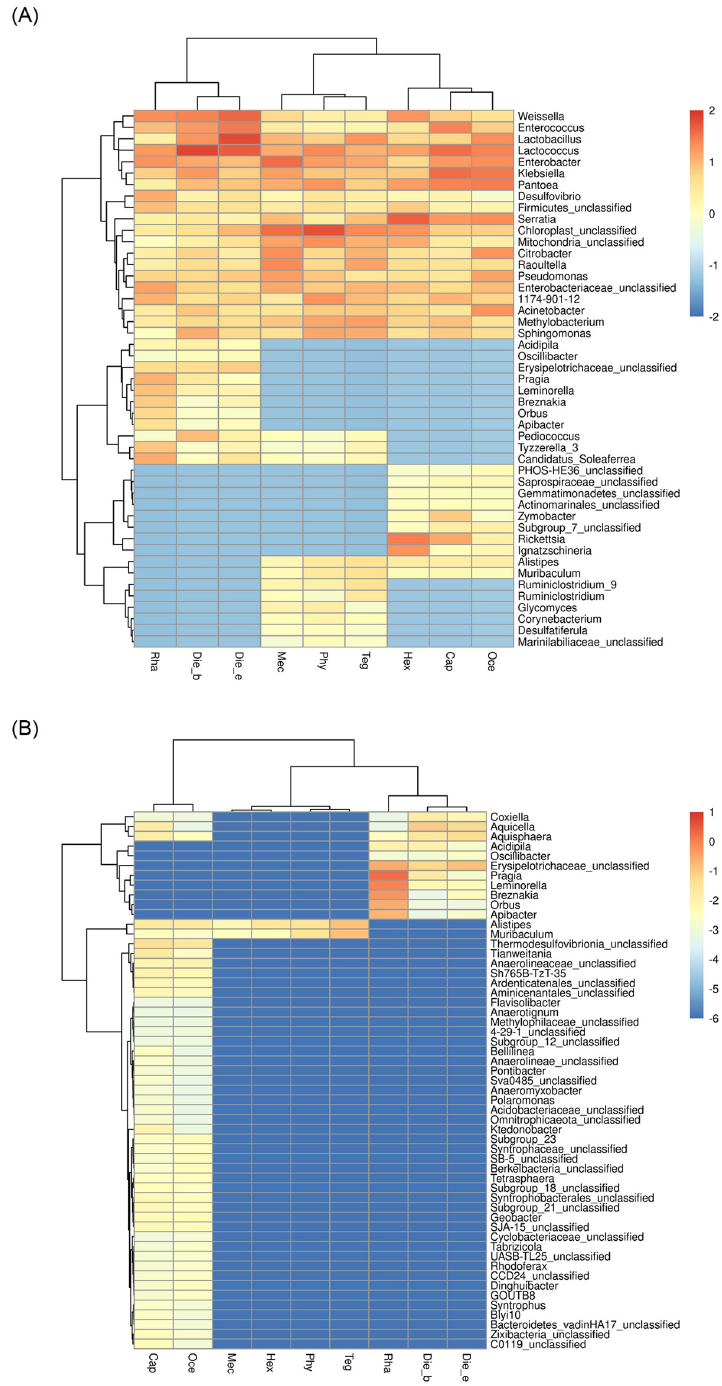
Fig 7. Heat map illustrating the common and endemic bacteria community abundances according to insects feeding habits (A) and insects taxonomy (B) at the genus level. The color scale of higher (red) and zero (blue) show the relative abundances of bacterial